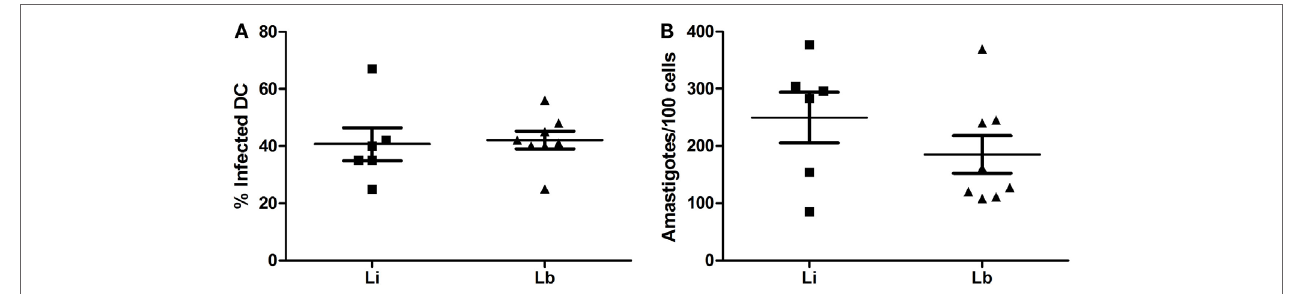
FigUre 1 | Dendritic cells’ infection by L. infantum (li) or L. braziliensis (lb) – immature Dcs were infected in a rate of 10 Leishmania to 1 Dc . Infection after 24 h, in hematoxylin–eosin (HE)-stained slides. Median ± SD. Each point represents one donor. * p < 0.01. (a) Percentage of infected DCs. (B) Amastigotes per 100